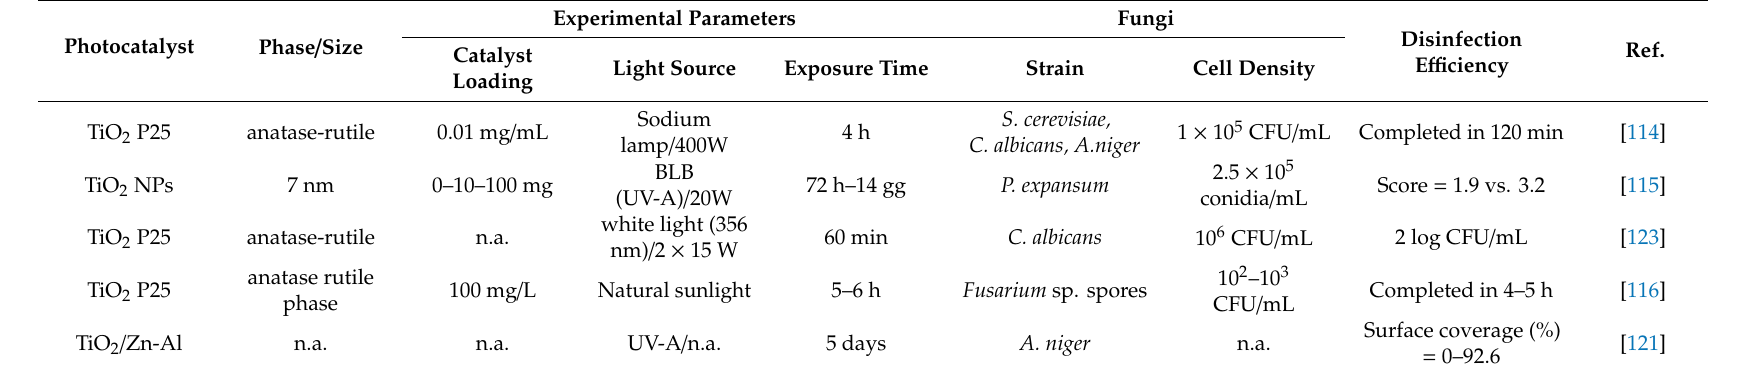
Table 3. Summary of the experimental conditions reported in literature for TiO 2 -based nanomaterials photocatalyzed fungal